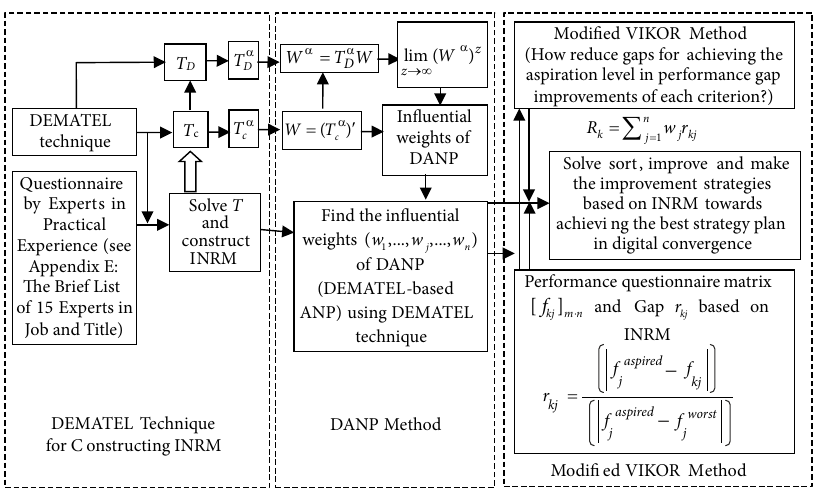
Fig. 1. Model procedures of new hybrid